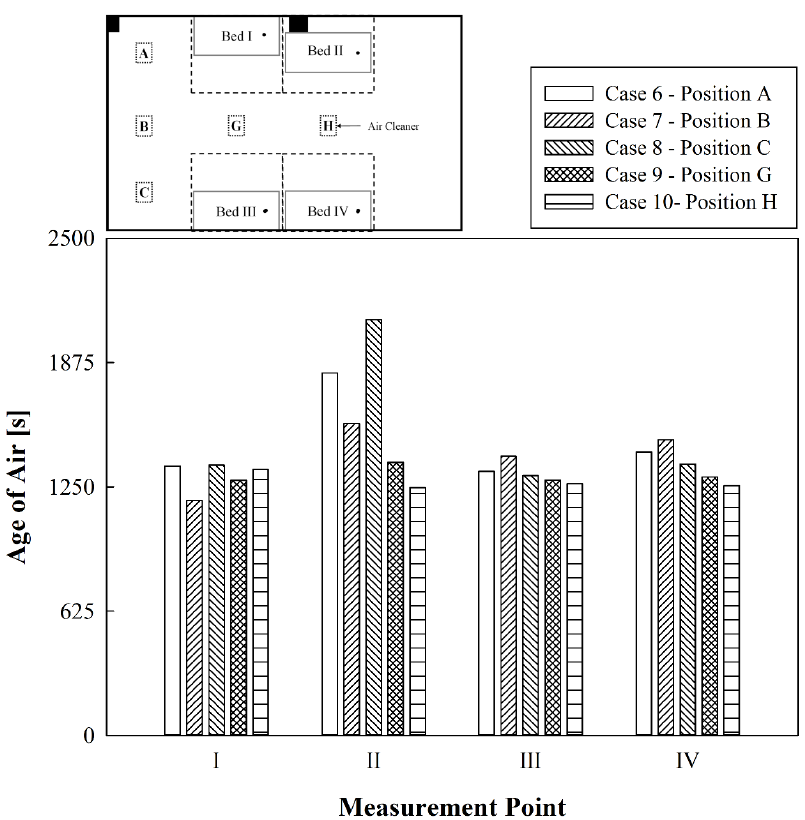
Figure 7. Comparative results of the age of air at locations where only the air cleaner was operated while using curtains.